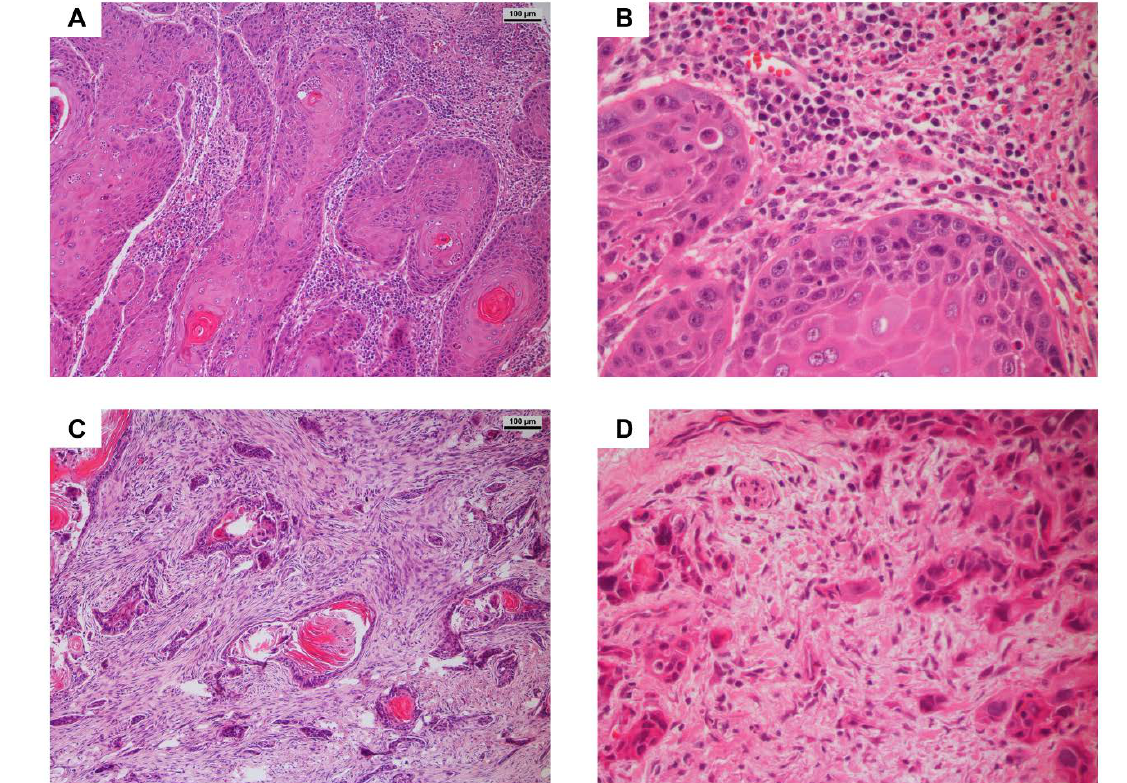
Figure 3. H&E-stained sections of OSCC (100× and 400× magnification). ( A , B ) Primary tumors clas- finger-like pushing fronts invading surrounding tissue. ( C , D ) Primary tumor with a score of 4 (aggressive pattern of invasion). Here, small cell islets are detached from the main tumor, infiltrating the healthy tissue. the healthy